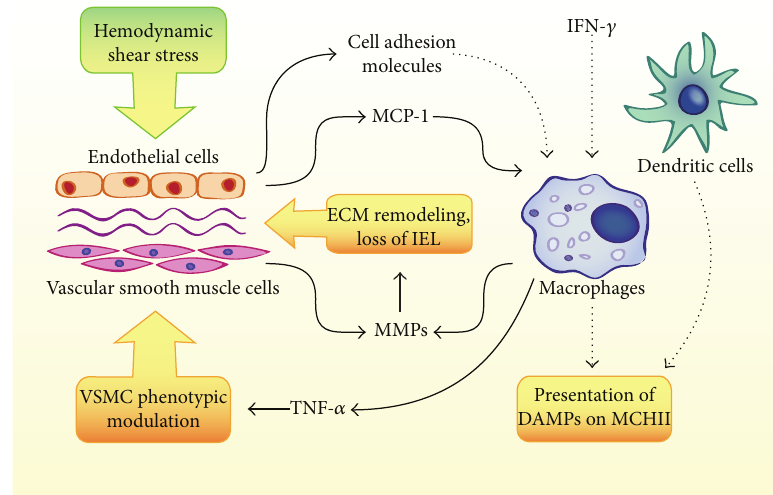
Figure 1: Summary of known and hypothesized contributions of macrophages and dendritic cells to intracranial aneurysm (IA). Interactions that have been demonstrated in IA models are depicted with solid arrows. Additional mechanisms that may be hypothesized based on other vascular inflammatory diseases are depicted with dotted arrows. Hemodynamic shear stress contributes to the recruitment of macrophages to the aneurysm wall via expression of MCP-1, a process that may also be aided by cell adhesion molecules. Macrophages are likely activated by IFN- 𝛾 and have been shown to contribute to IA by the secretion of TNF- 𝛼 and MMPs. Additionally, macrophages and dendritic cells could contribute to inflammation via the presentation of DAMPs (such as oxidized lipids) on